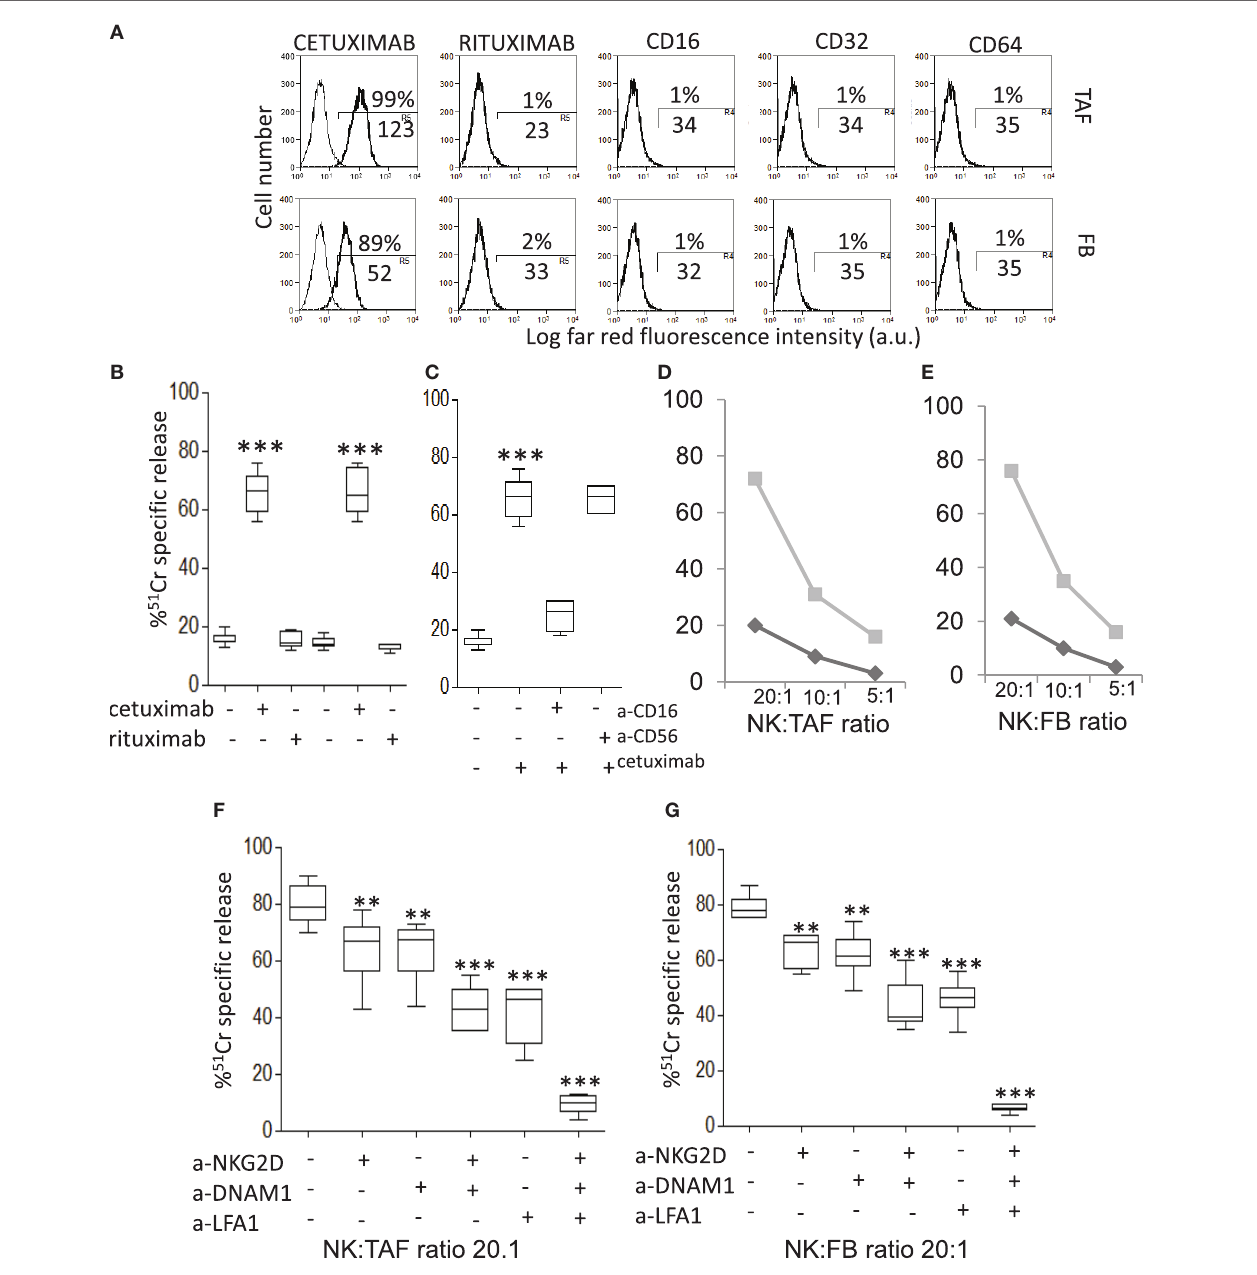
FigUre 3 | CRC-derived tumor-associated fibroblasts (TAF) can be targeted with cetuximab and killed by natural killer (NK) cells. (a) Mesenchymal stromal cells (MSC) from either CRC (TAF, upper row) or tumor free (FB, lower row) colon mucosa were assessed for the reactivity with cetuximab or rituximab (control isotype-matched antibody), as indicated, by indirect immunofluorescence with the specific Ab followed by AlexaFluor647 anti-human antiserum and FACS analysis. The expression on MSC of CD16 (Fc γ RIII), CD32 (Fc γ RII), and CD64 (Fc γ RI) antigens, upon immunofluorescence with specific mAbs followed by AlexaFluor647 goat anti-mouse (GAM), is also shown. In each panel: negative control (anti-human antiserum or GAM alone, thin black line) and reactivity with the indicated antibody (thick black line). Numbers in each subpanel are the percentage above the bar and the mean fluorescence intensity (MFI, below the bar, a.u.) of positive cells. (B) Antibody-dependent cellular cytotoxicity (ADCC) of TAF by NK cells at the NK:TAF ratio of 5:1 was evaluated with cetuximab or rituximab (2 µg/ml). ( c) Cetuximab-mediated ADCC of TAF in the presence of the anti-CD16 monoclonal antibody (mAb) or the control anti-CD56 mAb (2 µg/ml). (D,e) Cytolysis exerted by resting (black) or IL-2-activated (gray) NK cells at the indicated effector:target ratio (20:1, 10:1, 5:1) against TAF (D) or FB (e) . (F,g) Effect of anti-NKG2D, anti-DNAM1, and anti-lymphocyte function associated (LFA)1 mAbs (2 µg/ml) on TAF (F) or FB (g) lysis exerted by IL-2-activated NK cells at 20:1 effector:target ratio. Results are shown as percentage of 51 Cr-specific release and are the mean with boxes and whiskers min to max of six independent experiments with matched TAF and FB from six different patients. *** p < 0.0001; ** p <